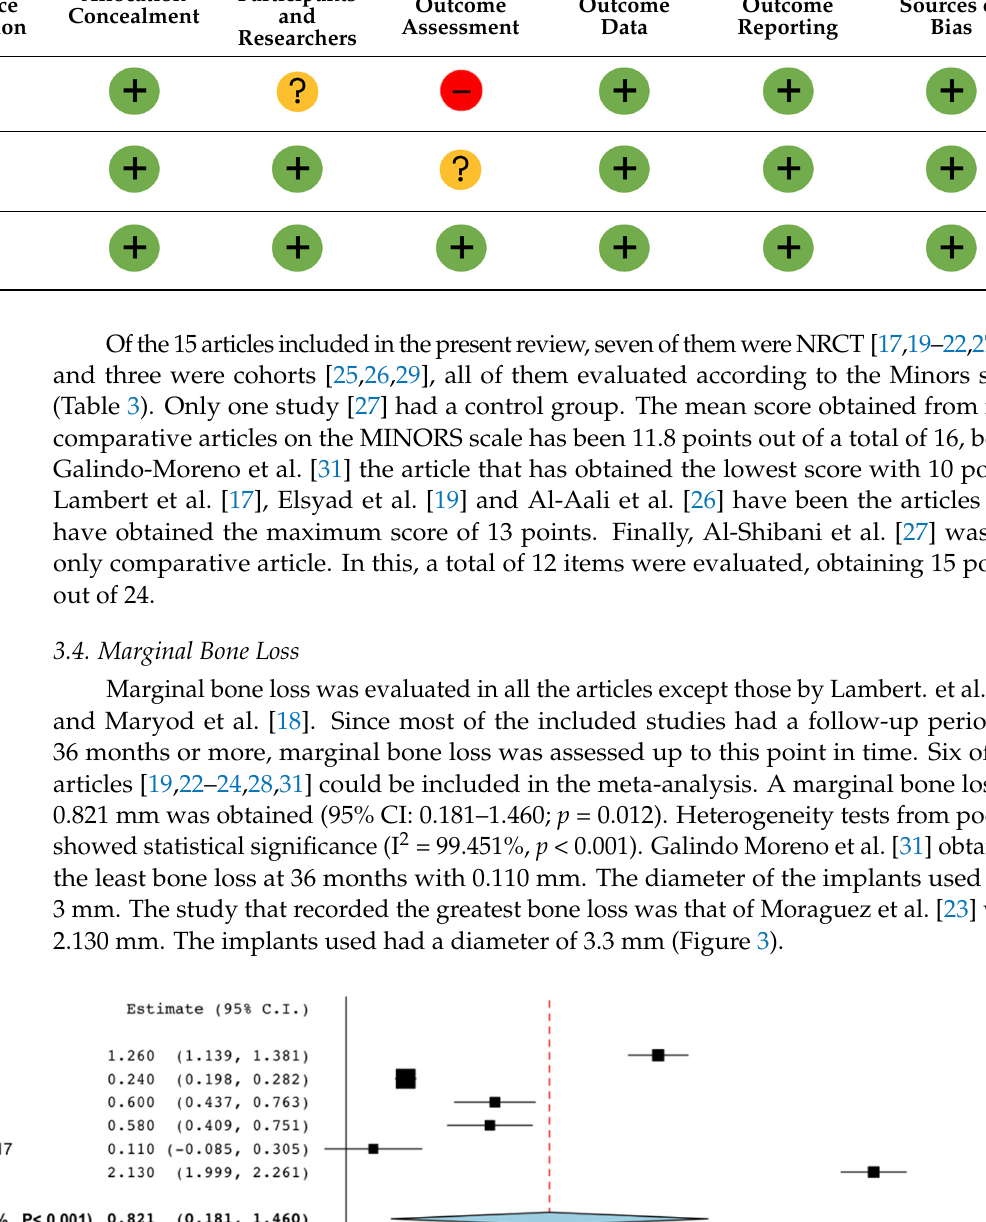
Table 2. Risk of Bias of included randomized clinical trials. +: Low; ?: Unclear; − : High.